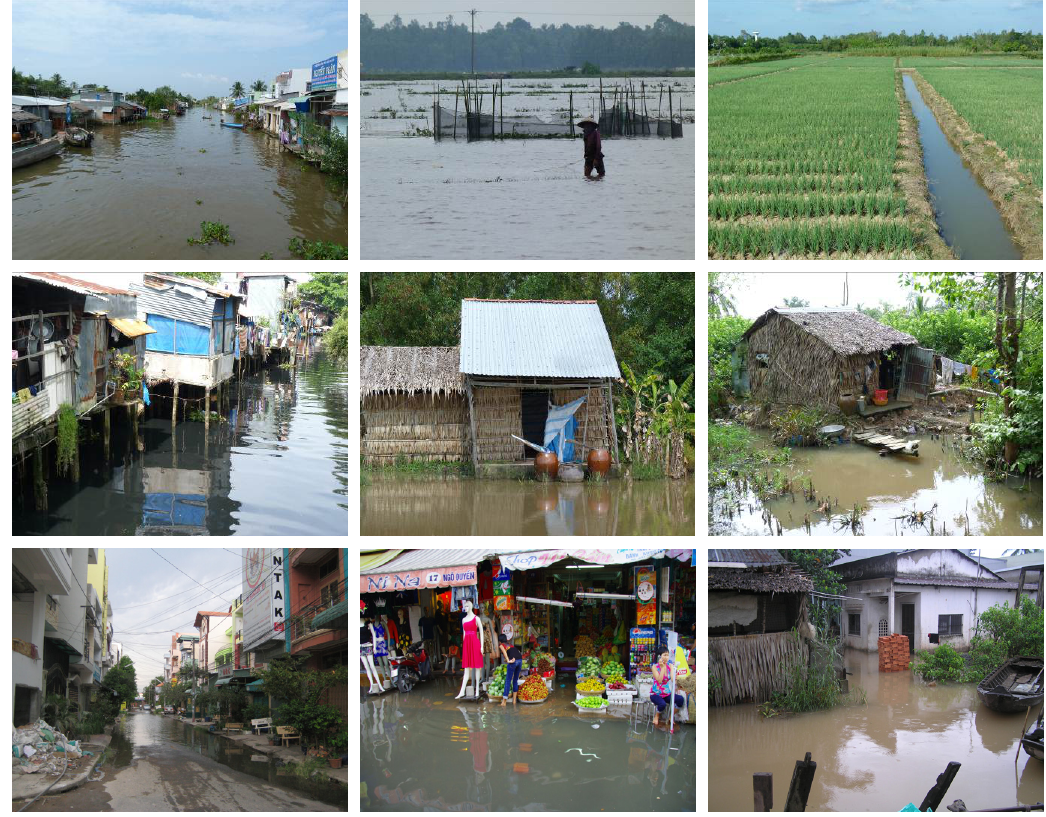
Figure 2. Impressions of Can Tho province and typical flood situations. Upper left: many people live along canals, which ensure water supply and transport. Upper middle: during high flood stages many fields in the province are inundated via river-induced and overland flow, and people use this time for fishing. Upper right: Rice and vegetable crops profiting from nutrient-rich waters are grown throughout the province. Middle left: Many inhabitants need to elevate their houses. During exceptionally high flood pulses or high tide events people close to canals often have water seeping into their ground floor. Middle middle and right: impression of a rural farmer’s houses surrounded by water. Lower row: flooded roads and places within urban residential areas (upper six photographs taken by C. Kuenzer in the Mekong Delta, November 2011, lower middle and right photograph courtesy of M. Garschagen